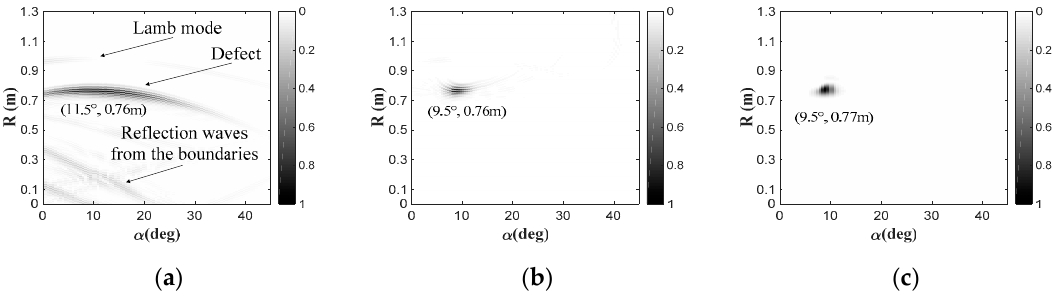
Figure 9. The results for the angular step 0.5° by different methods: ( a ) B-scan, ( b ) delay and sum (DAS), ( c ) circumferential synthetic aperture focusing technique (CSAFT). The excitation signal is a tone-burst signal with three cycles.